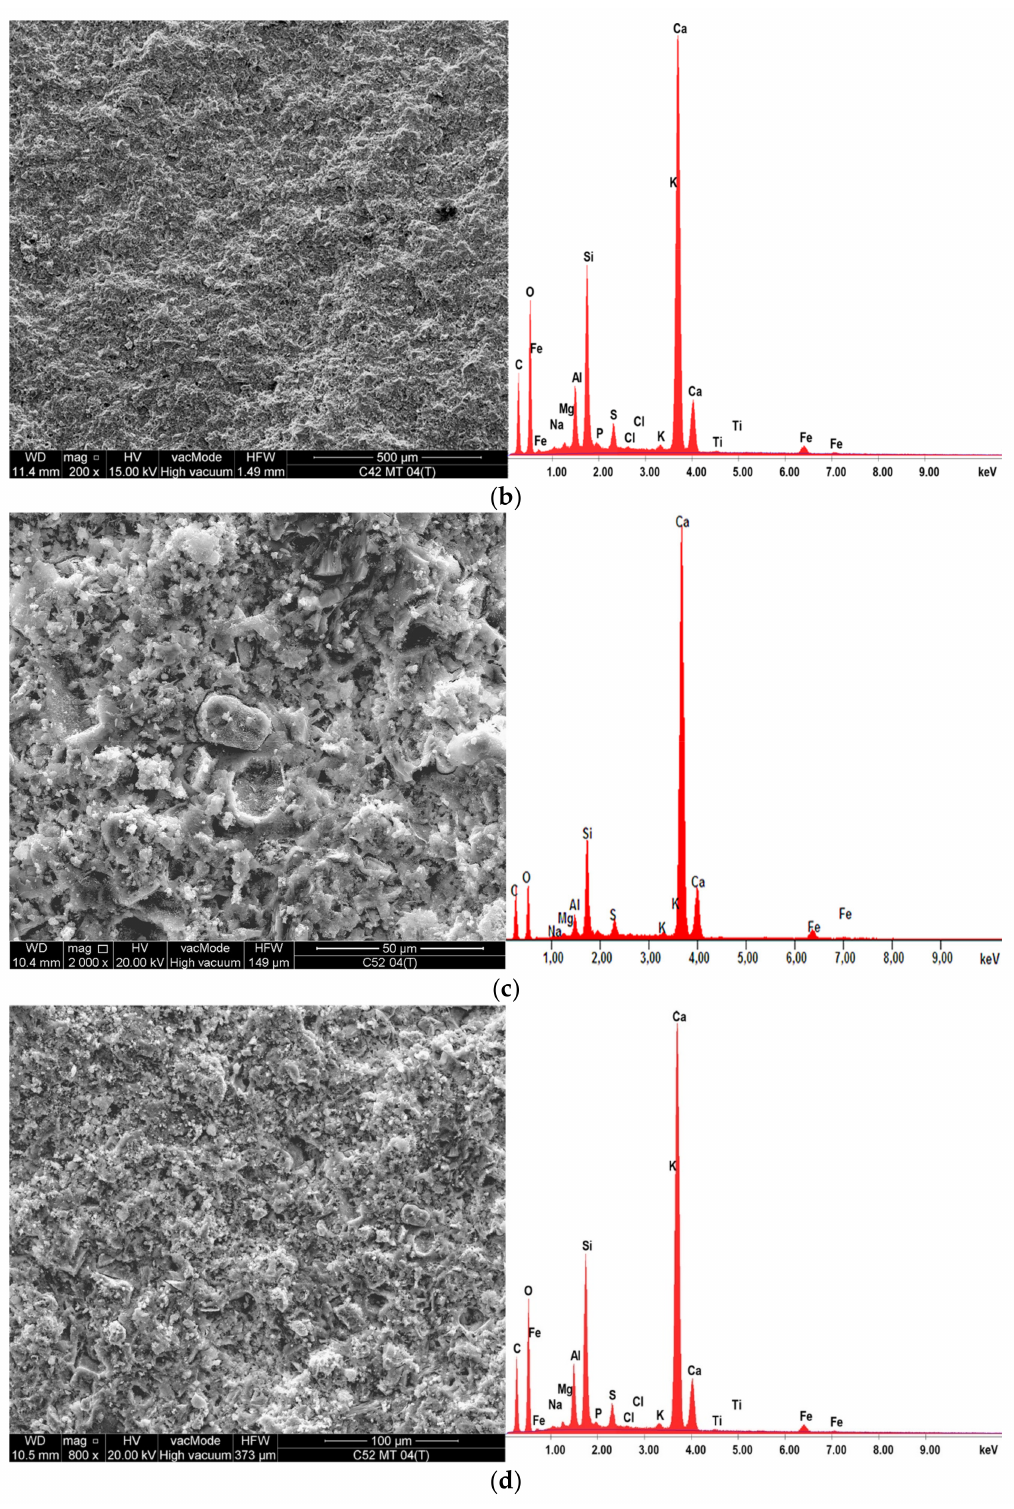
Figure 12. The EDS spectra of the samples tested after thermal action together with the SEM image of the area analyzed: ( a ) C42; ( b ) C42MT; ( c ) C52; ( d )